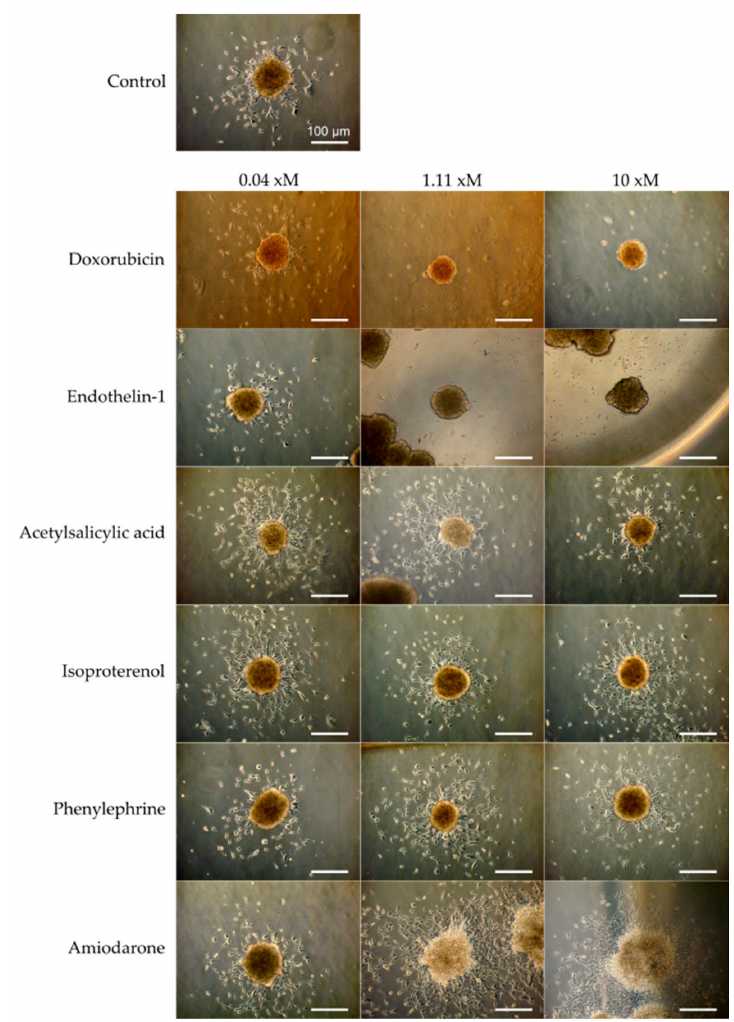
Figure 5. Micrographs of cardiac spheroids (SFC086) showing the outgrowth of cells from the aggregates and the effect of six drug compounds at three concentrations after 48 h on the number of cells around the spheroids. For endothelin-1, x = n (nM). For all other compounds, x = µ ( µ M). Scale bar represents 100 µ